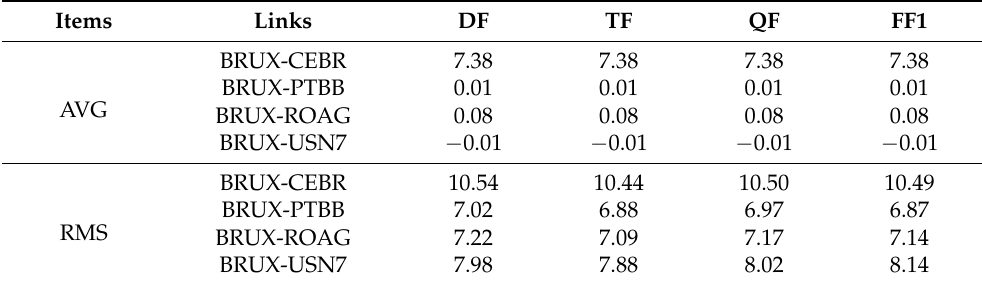
Table 4. Clock offset epoch difference results of average (AVG) and root mean square (RMS) at four time-frequency links for the DF, TF, QF and FF1 PPP models on DOYs 190 to 196 in 2020 (ps).